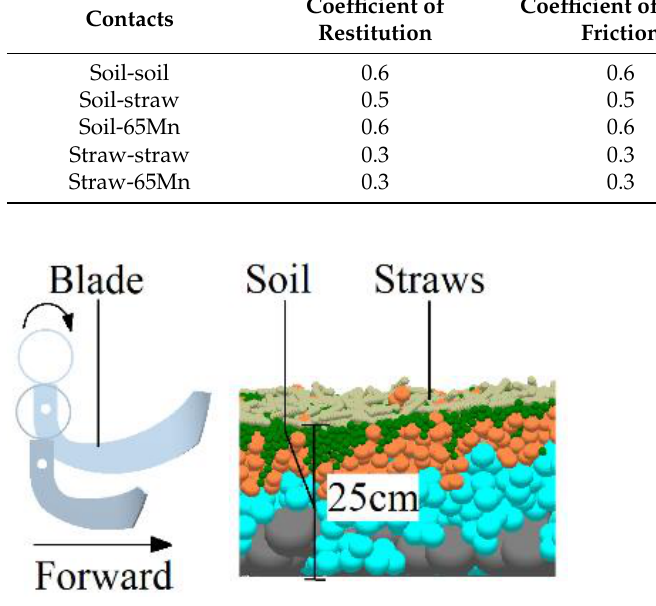
Figure 5. The discrete element model.